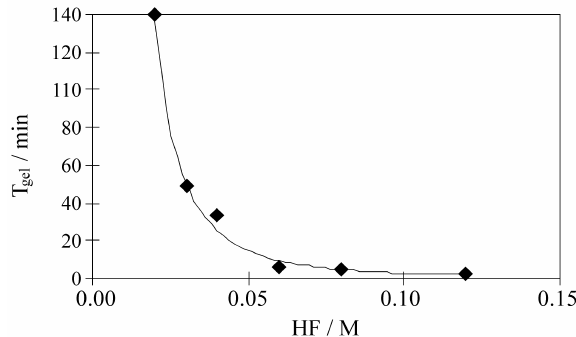
Figure 1. Gelation time as a function of HF concentration.